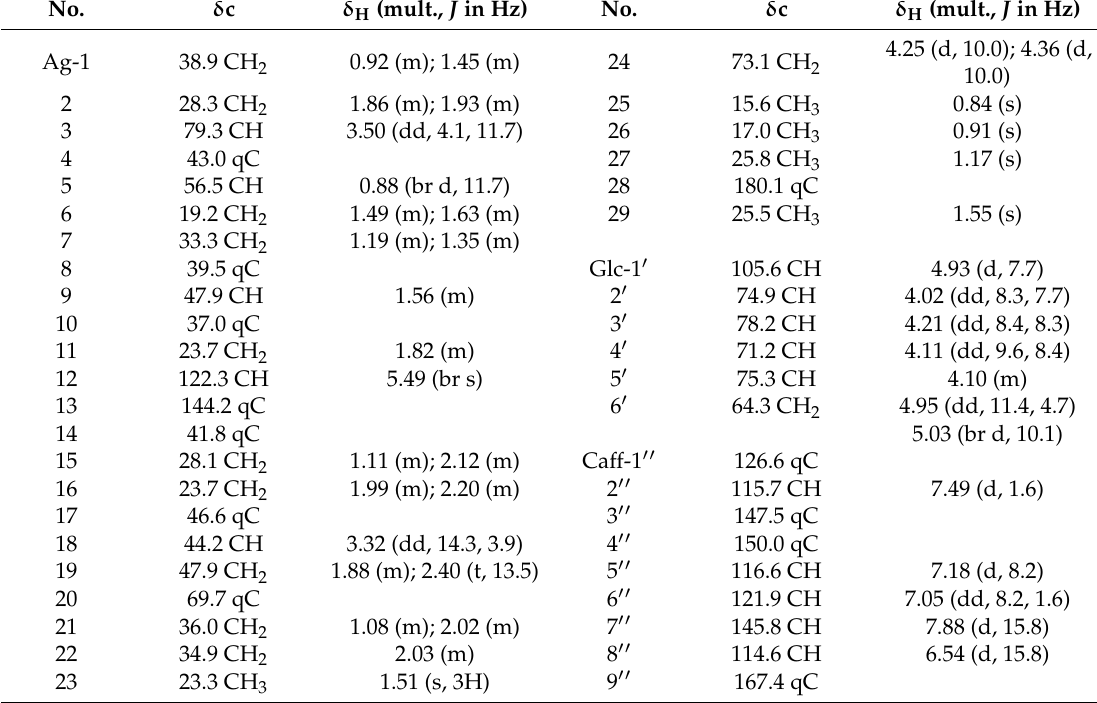
Table 3. NMR spectroscopic data for compound 3 in pyridine- d 5